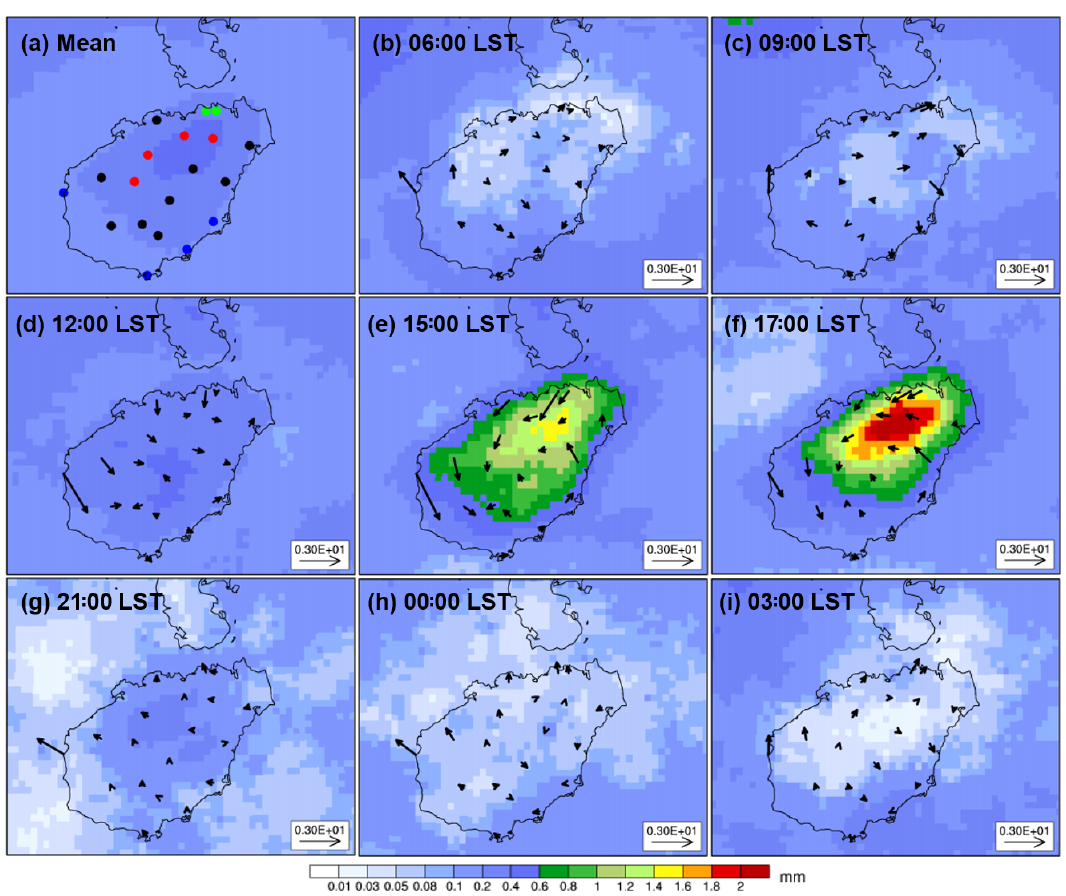
Figure 6. Ten-year average of hourly rainfall accumulations at 3h intervals for May and June derived from CMORPH (shading) except 17:00LST is used as it is the strongest rainfall time in the CMORPH observation. Three-year average wind velocity (vectors) is also shown. Rain gauge locations are indicated in (a)